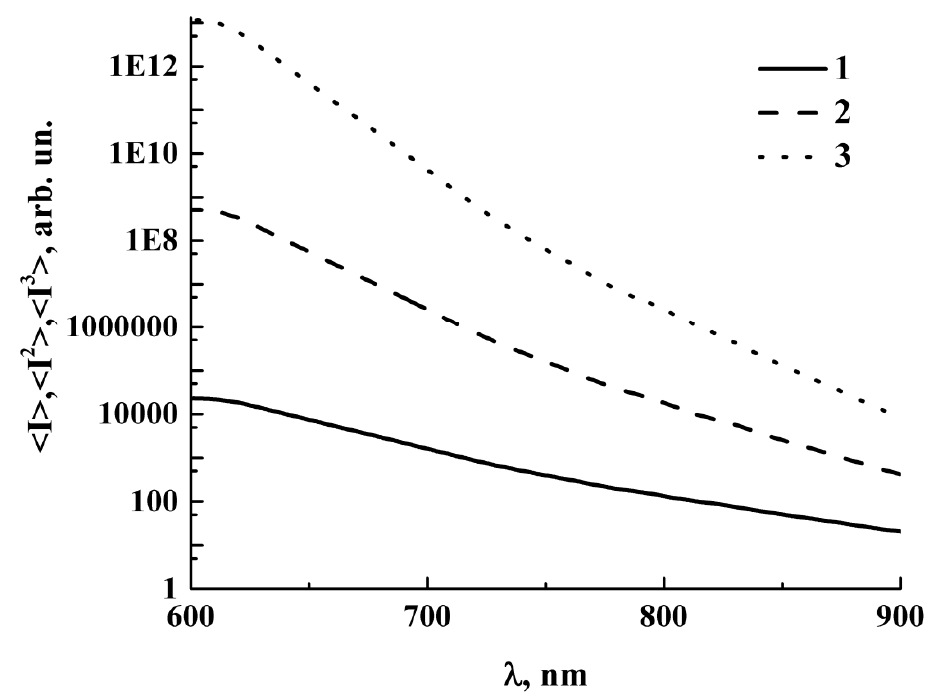
Figure 5. Spectral dependencies of the statistical moments of fluorescence intensity fluctuations obtained in the course of the TiO 2 sample scanning. 1— (cid:104) I (cid:105) ; 2—